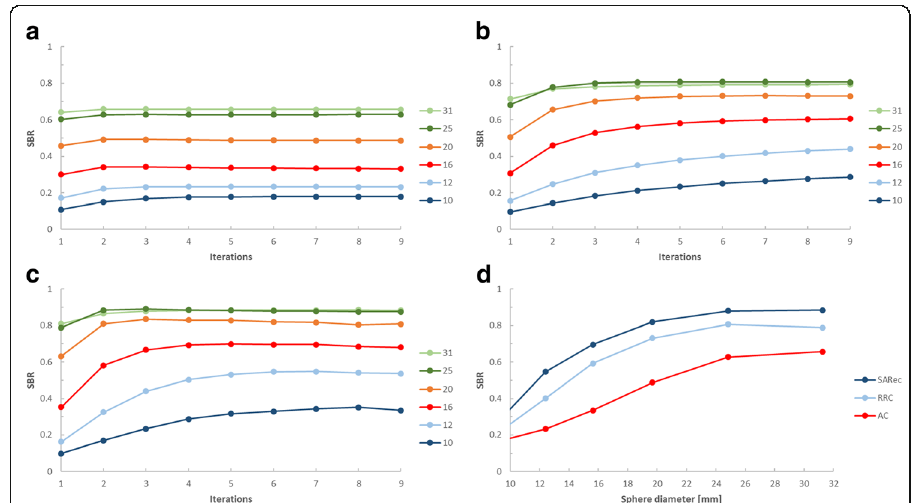
Fig. 4 The activity recovery (or normalized signal-to-background ratio (SBR)) for the different SPECT reconstructions versus the number of iterations of the 177 Lu-filled Jaszczak phantom. a AC-OSEM. b RRC-OSEM. c SARec OSEM. The curves show the SBR versus the number of iterations for the six spheres with diameters 10, 12, 16, 20, 25, and 31 mm, respectively. In panel d , the SBR versus sphere diameter for six iterations are shown for the AC-OSEM (AC), RRC-OSEM (RRC), and SARec OSEM (SARec)